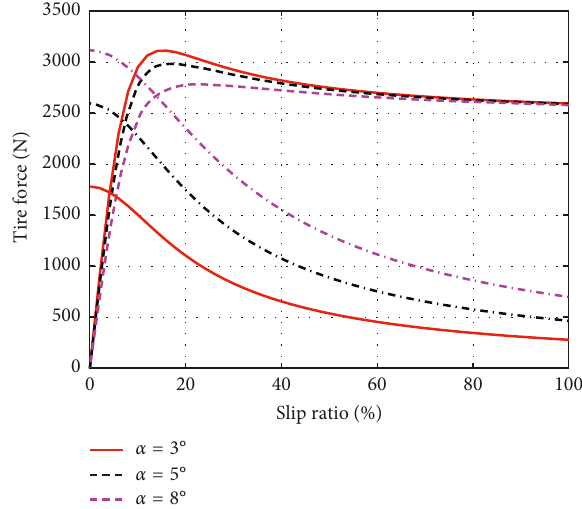
Figure 4: Tire force under different